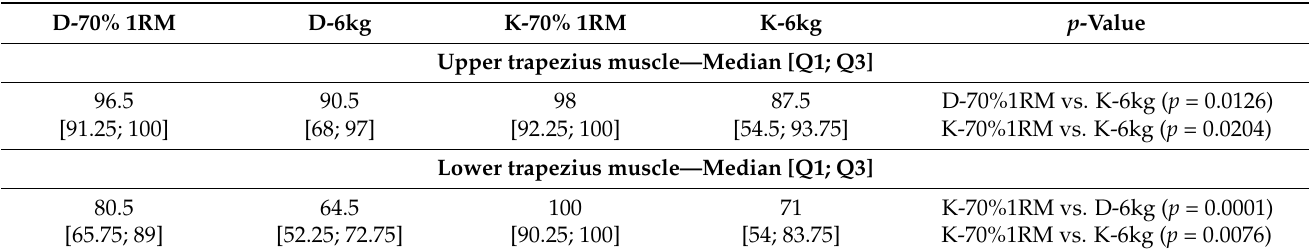
The p -values are for the Dunn Bonferroni post-hoc